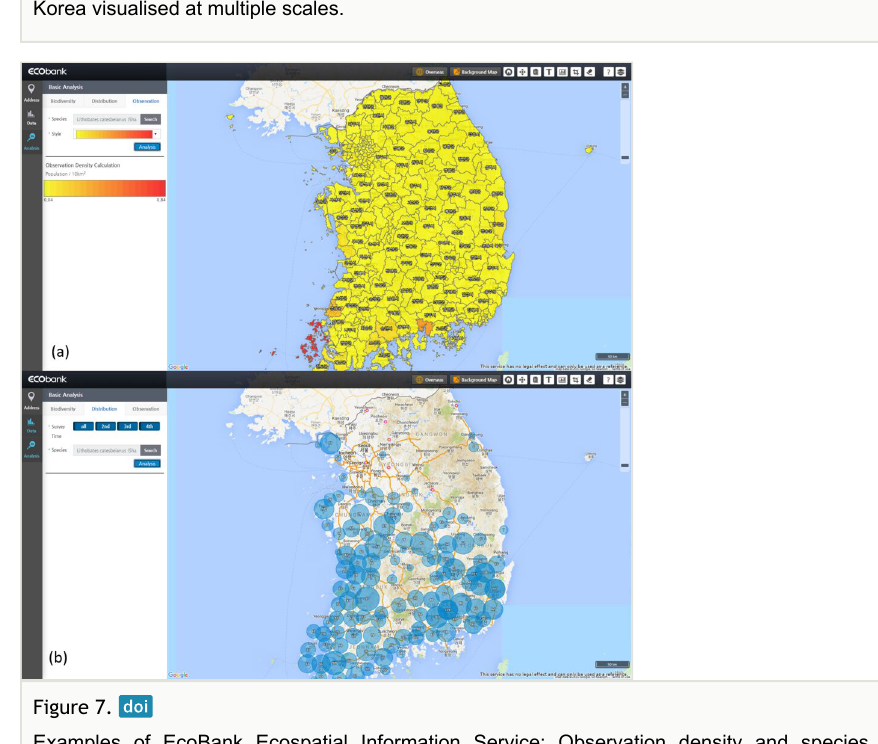
Examples of EcoBank Ecospatial Information Service: Observation density and species distribution of American bullfrog ( Lithobates catesbeianus ) for policy-makers. a ) Observation density; b) Species